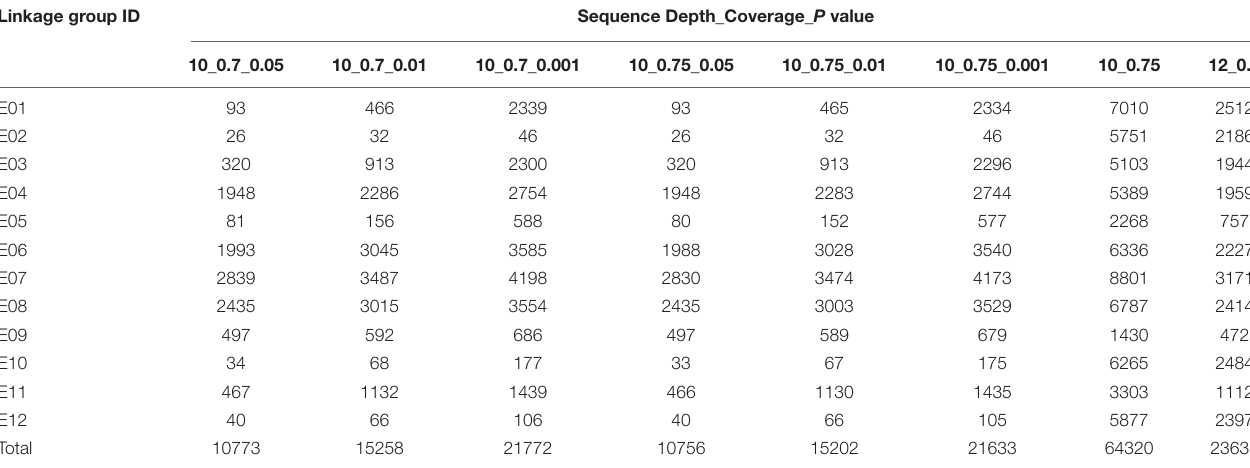
TABLE 1 | Number of SNP markers retained using different filtering parameters in 12 eggplant linkage groups. Linkage group